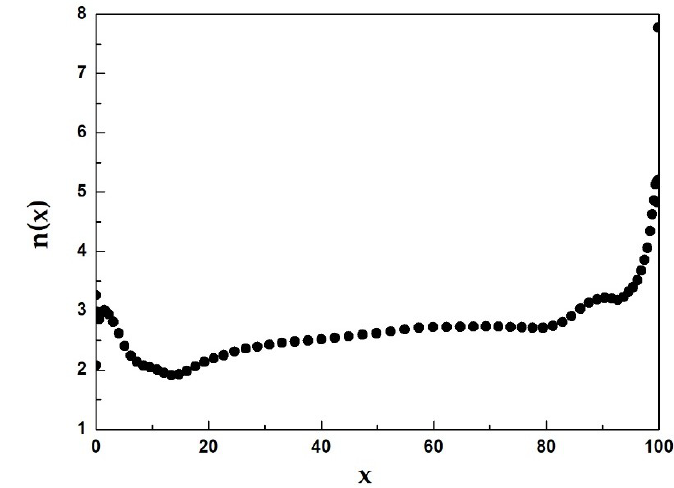
Figure 10. Variation of the local Avrami exponent with crystallized volume fraction for the W particles/Zr 41.2 Ti 13.8 Cu 12.5 Ni 10 Be 22.5 metallic glass matrix composite.